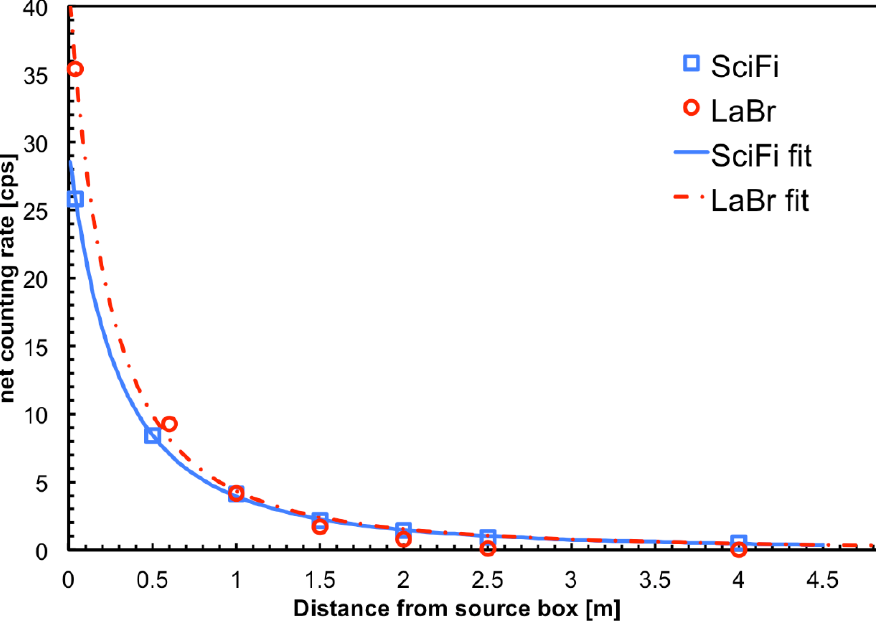
Figure 21. Net count rate as a function of the distance from the source wall, for the SciFi n.12 and the LaBr detectors. A data fit is also shown and the fit coefficients are listed in Table 3. Table 3. Results of an inverse squared distance fit to the SciFi and LaBr count rates as a function of the distance from the source wall.